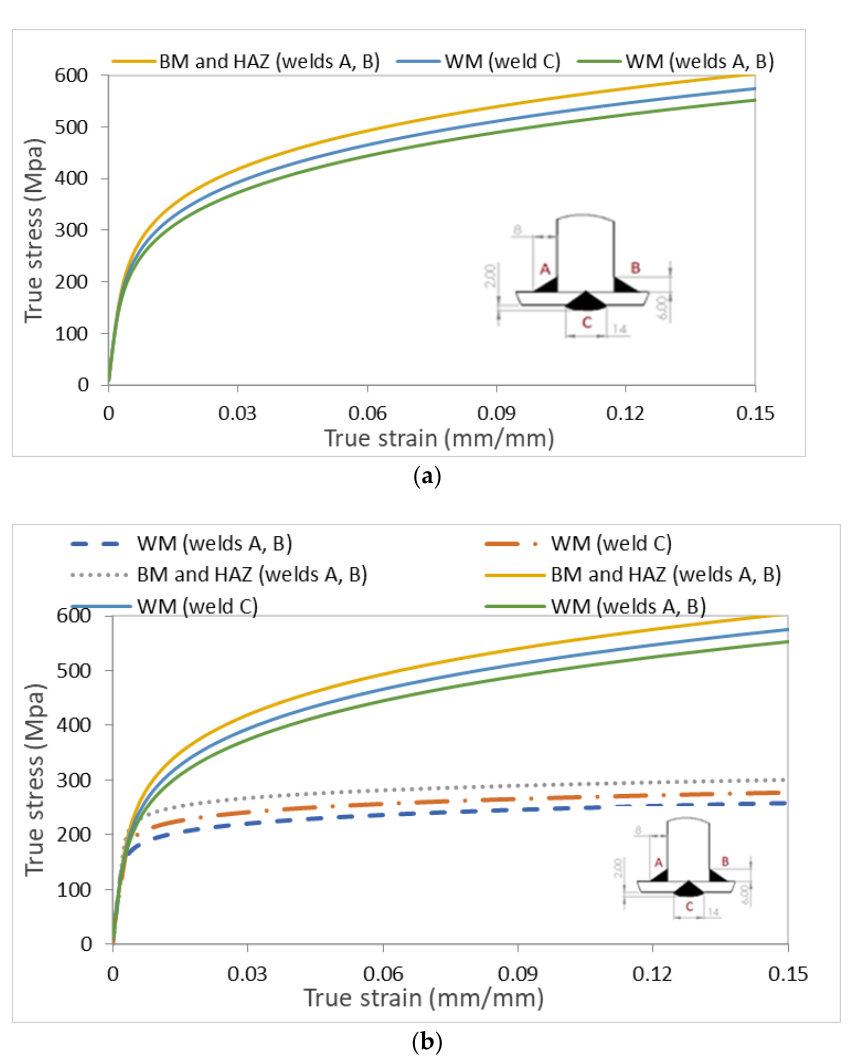
Figure 3. ( a ) Cyclic stress–strain curves calculated with data from hardness test, ( b ) Stress–strain curves from hardness. Static: dotted lines; cyclic: continuous lines.